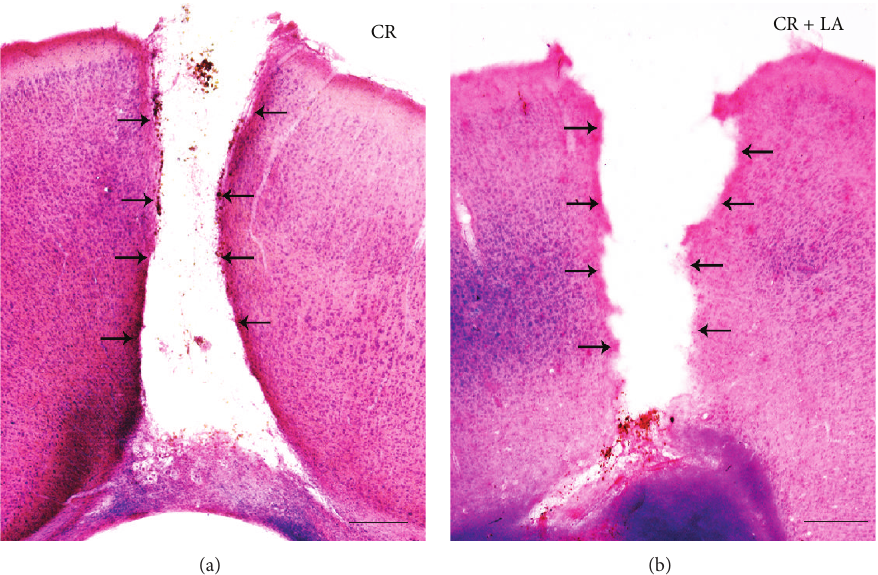
Figure 1: Hematoxylin-eosine staining of the injury area 60 days after the brain cryoinjury in untreated animals (a) and LA treated animals (b). Arrows indicate the edge of the injury. Scale bar: 500 𝜇 m.